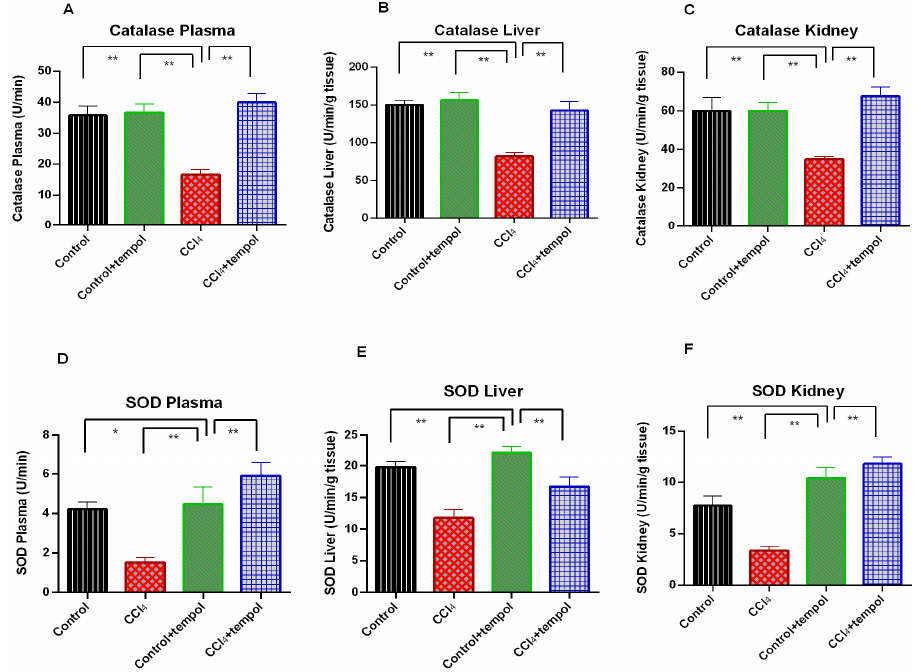
Figure 4. Effect of tempol on antioxidant enzyme activity in CCl 4 -administered rats. In this figure ( A ) Catalase Plasma, ( B ) SOD Plasma, ( C ) Catalase Liver, ( D ) SOD Liver, ( E ) Catalase Kidney, ( F ) SOD Kidney. Every value was represented as mean ± SEM. N = 6. One-way ANOVA followed by Tukey’s test were performed for statistical analysis. For statistical significance, p < 0.05 is considered significant in all cases. Here, * means p < 0.05, ** means p <